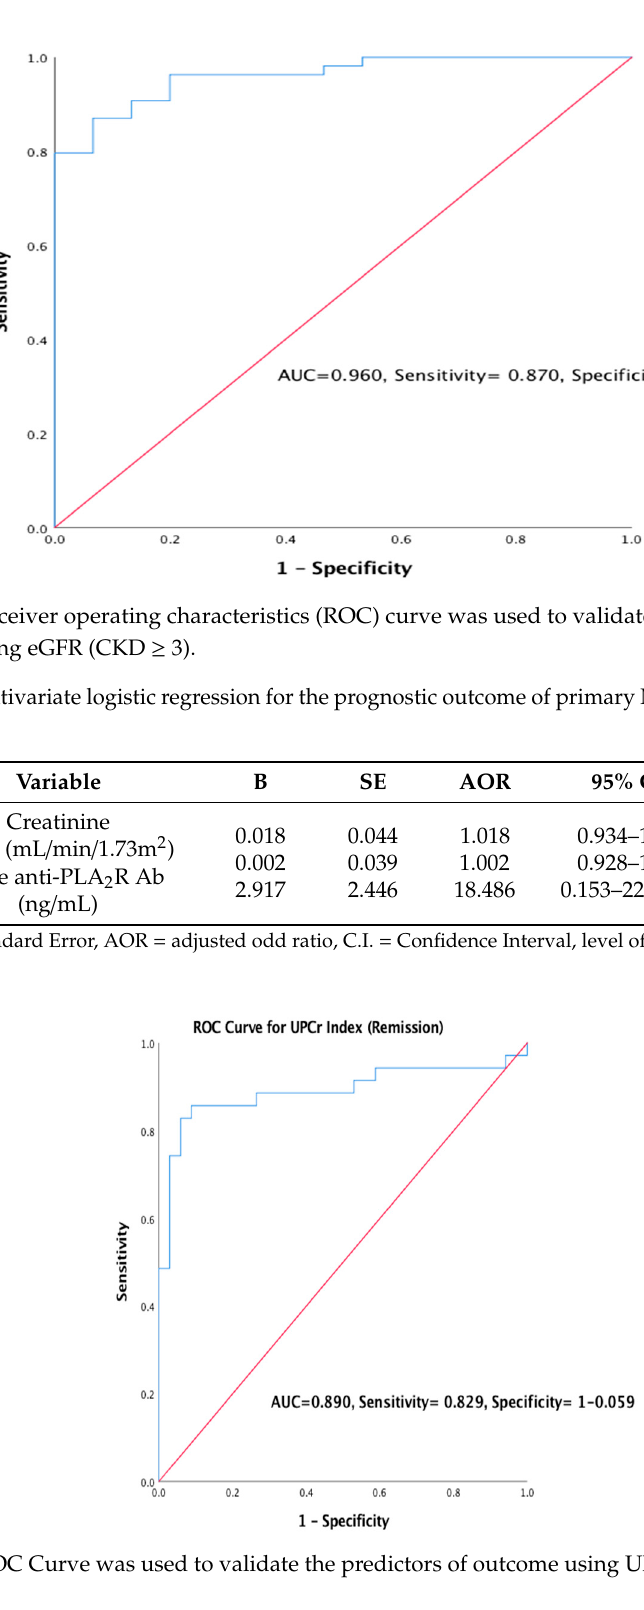
Table 6. Simple logistic regression for the prognostic outcome of primary MGN using UPCr Index (Remission).